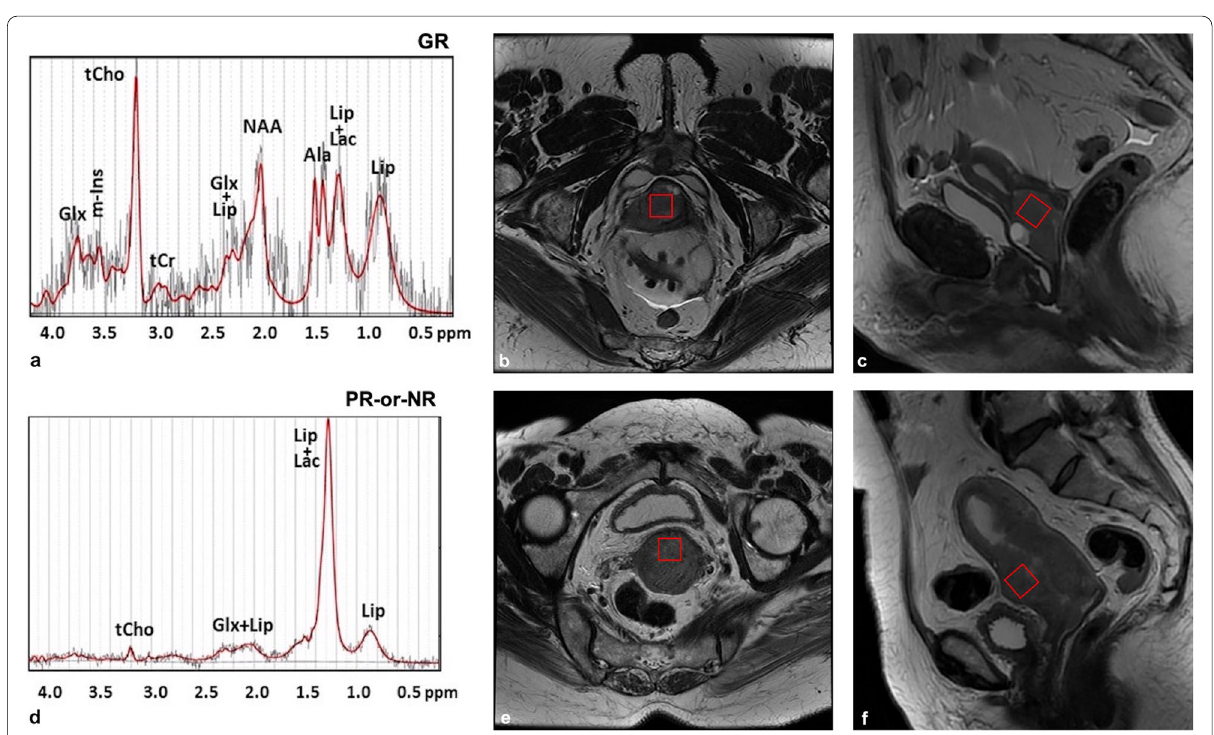
Fig. 1 Representative spectra (echo time 30 ms) of the two groups: ( a ) low and ( d ) high lipid level, corresponding to good responder patients (GR) and partial or nonresponder patients (PR-or-NR), respectively. Peak assignments: Glx, Glutamine plus glutamate; m-Ins, Myo-inositol; tCho, GPC plus PCho or total choline; tCr, Creatine plus phosphocreatine; Ala, Alanine; Lip, Lipids; Lac, Lactate. T2-weighted paraaxial ( b , e ) and sagittal ( c , f ) images of the two